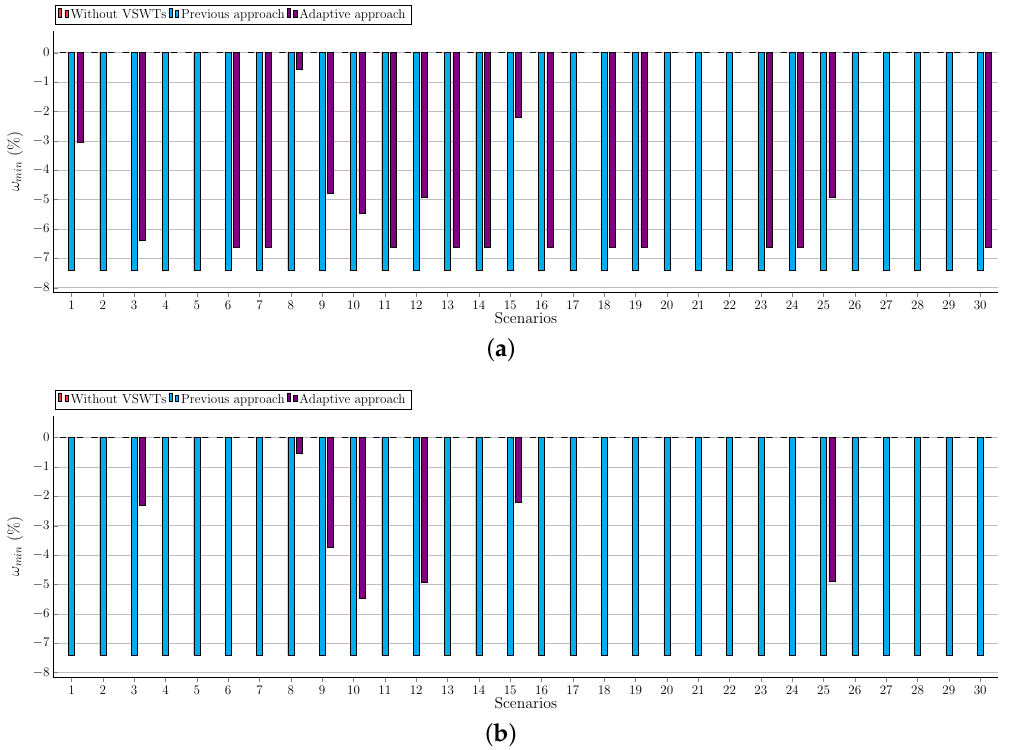
Figure 9. Minimum rotational speed ( a ) Largest power plant disconnection; ( b ) Second largest power plant disconnection.